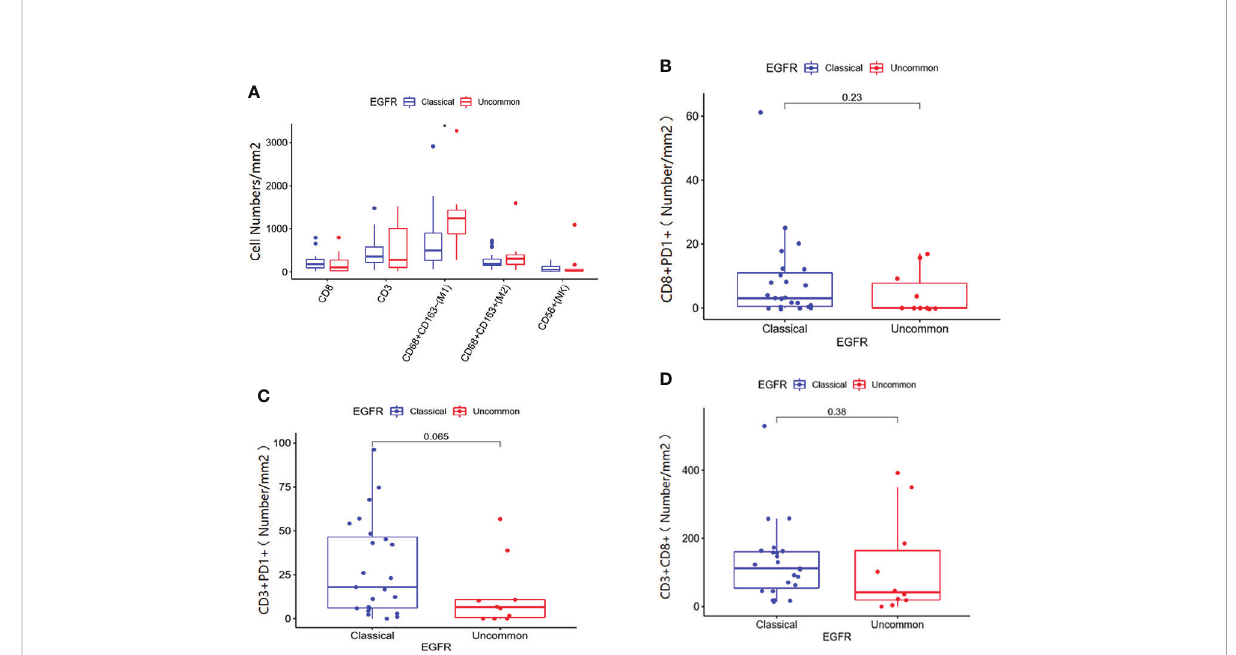
FIGURE 6 Immune cell in fi ltration in patients with classical EGFR mutations vs. uncommon EGFR mutations in clinical center data. (A) Comparison of immune cells in NSCLC patients from our clinical center between EGFR classical mutations and uncommon mutations. The in fi ltration of CD8 + PD1 + cells (B) , CD3 + PD1 + cells (C) , and CD3 + CD8 + cells (D) in patients with EGFR classical mutations and uncommon